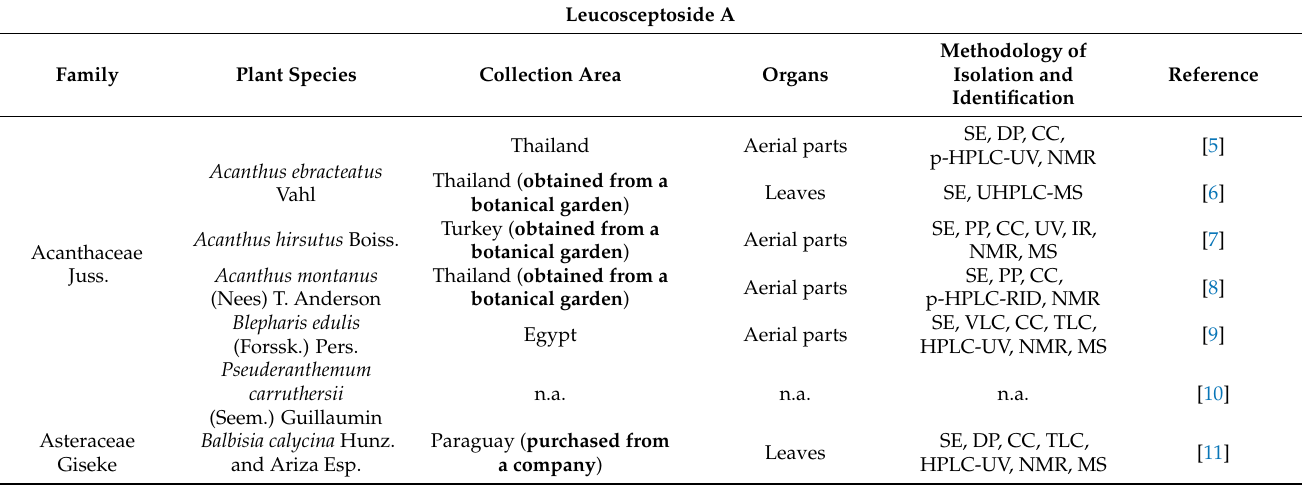
Table 1. Occurrence of leucosceptoside A in the plant